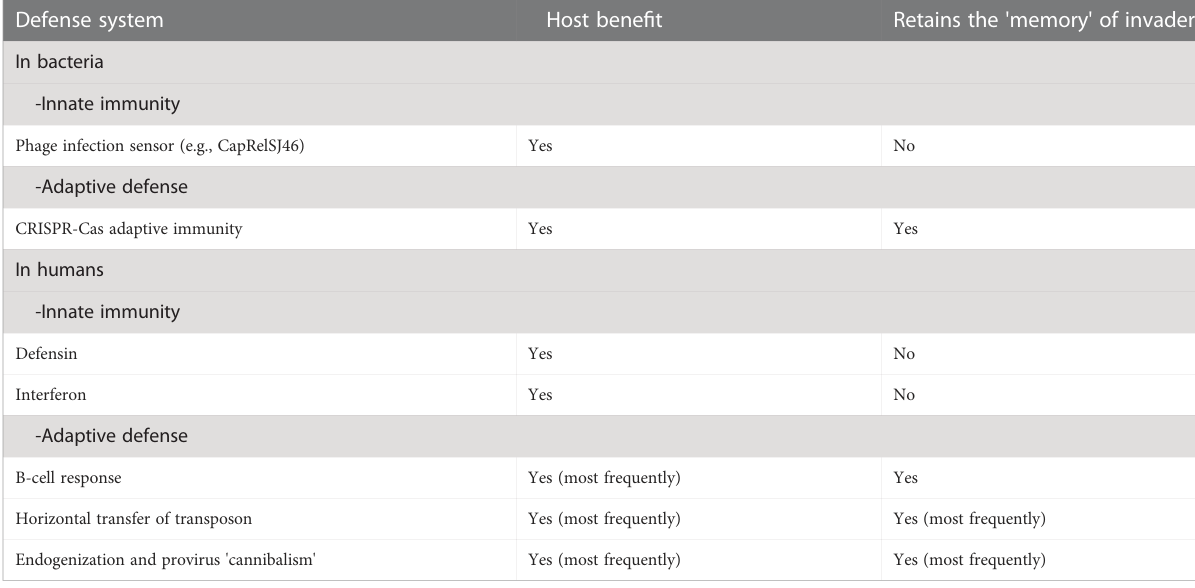
TABLE 1 Examples of the outcomes of host defense against microorganisms. Defense